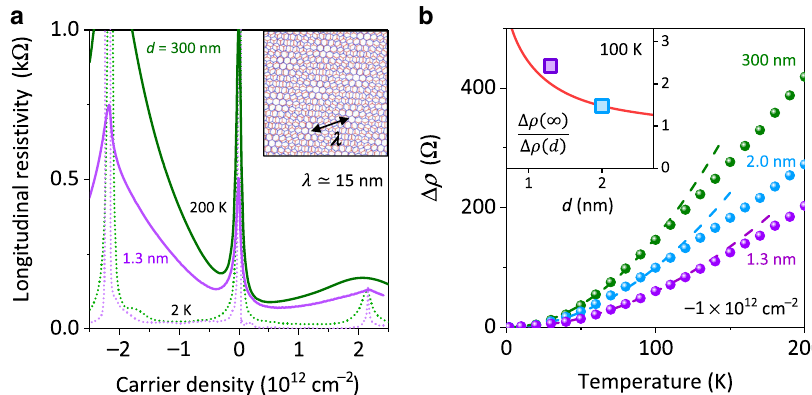
Fig. 3 Suppression of umklapp e – e scattering in graphene superlattices by proximity-gate screening. a ρ ( n ) of graphene-on-hBN superlattices for d (cid:3) 1 : 3 and 300 nm (purple and green curves, respectively). Dotted and solid curves: T ¼ 2 and 200 K , respectively. Inset: Illustration of the moiré pattern arising from crystallographic alignment between graphene and hBN lattices. b T -dependent part of ρ for superlattice devices with different d (color-coded symbols); n ¼ (cid:4) 1 ´ 10 12 cm (cid:4) 2 so that superlattices ’ fi rst Brillouin zones are approximately half- fi lled with holes 25 – 27 . Dashed curves: Best fi t to the predicted T 2 dependence 19 . All the devices had λ (cid:3) 15 nm and close ρ at 2 K . Inset: Δ ρ ð d Þ for the two close-gate superlattices normalized by Δ ρ 1ð Þ measured for the reference (far-gate) superlattice. The color-coded symbols in the inset are taken from the main panel and valid for all T ≤ 120 K because of the T 2 dependence. Solid curve: